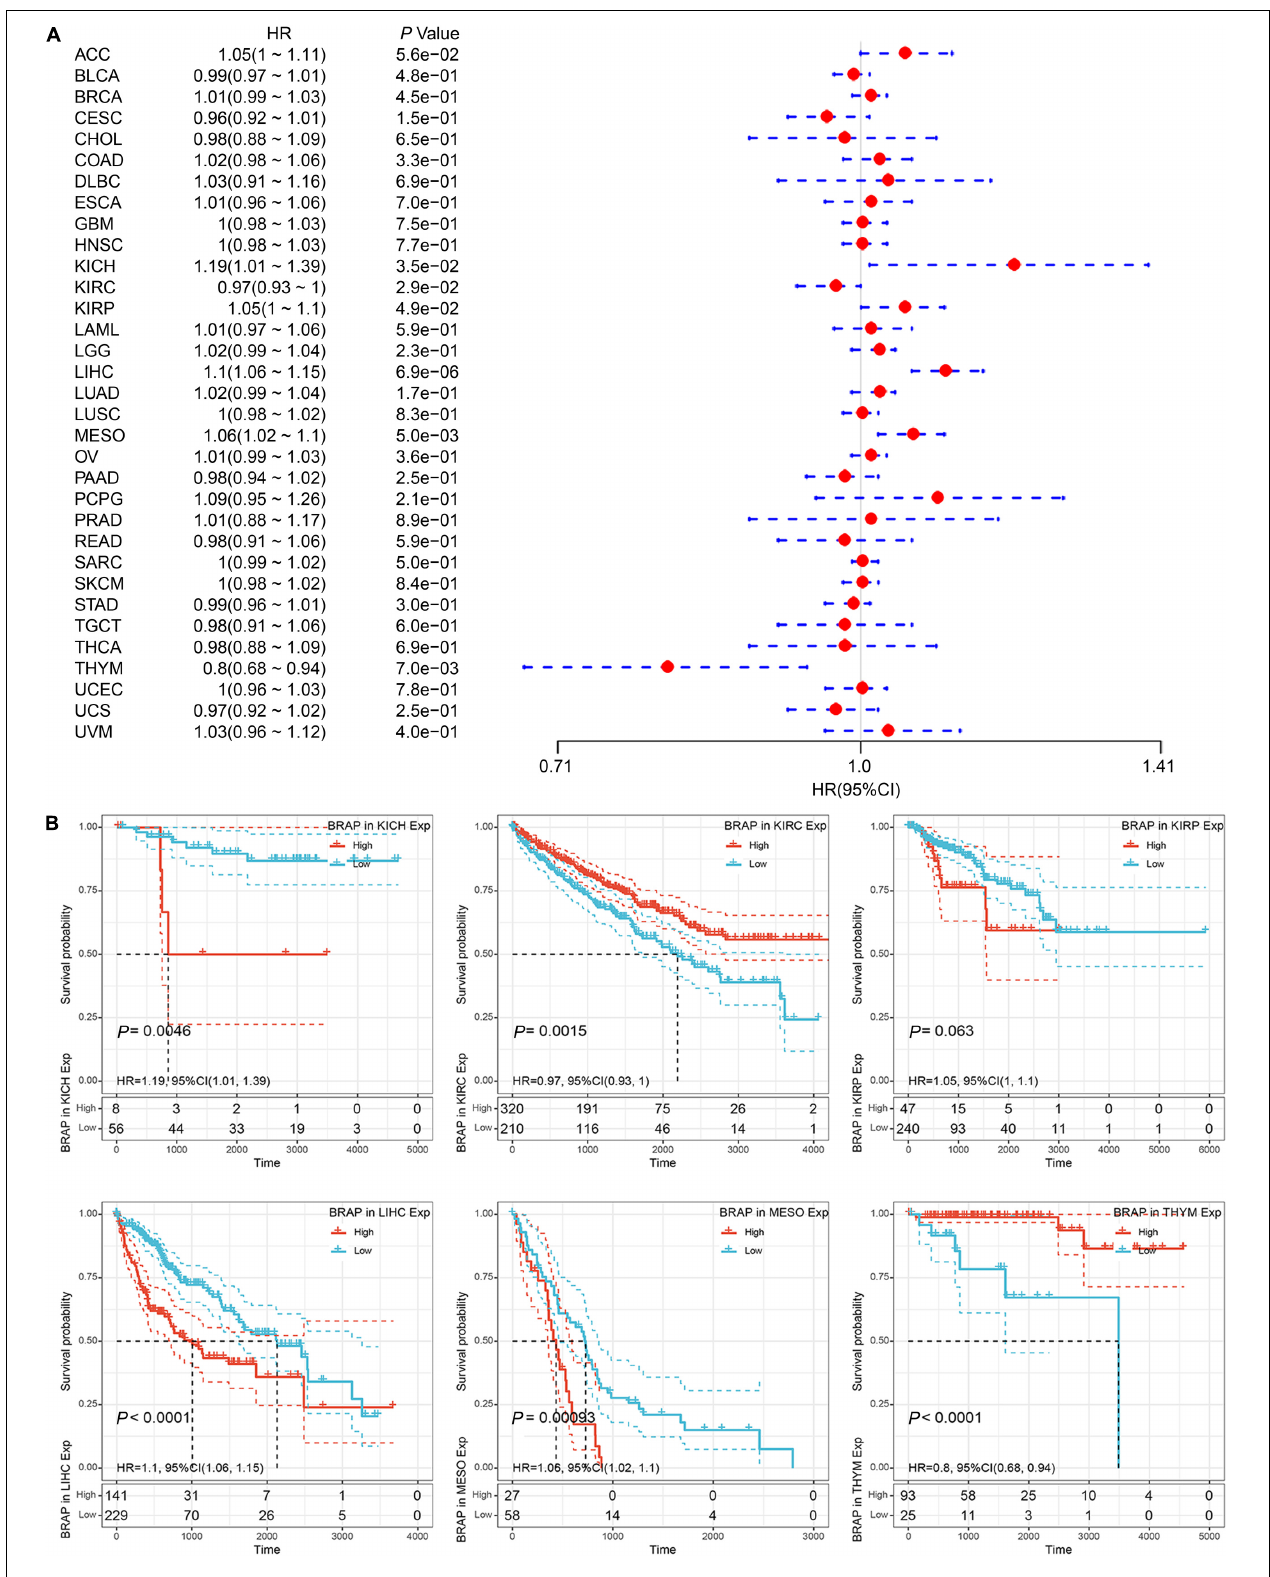
FIGURE 3 | Relationship of BRAP expression with patients’ OS. (A) Forest plots of hazard ratios of BRAP in 33 cancer types. (B) Kaplan–Meier OS curves for patients stratified by different expression levels of BRAP in six cancer types.